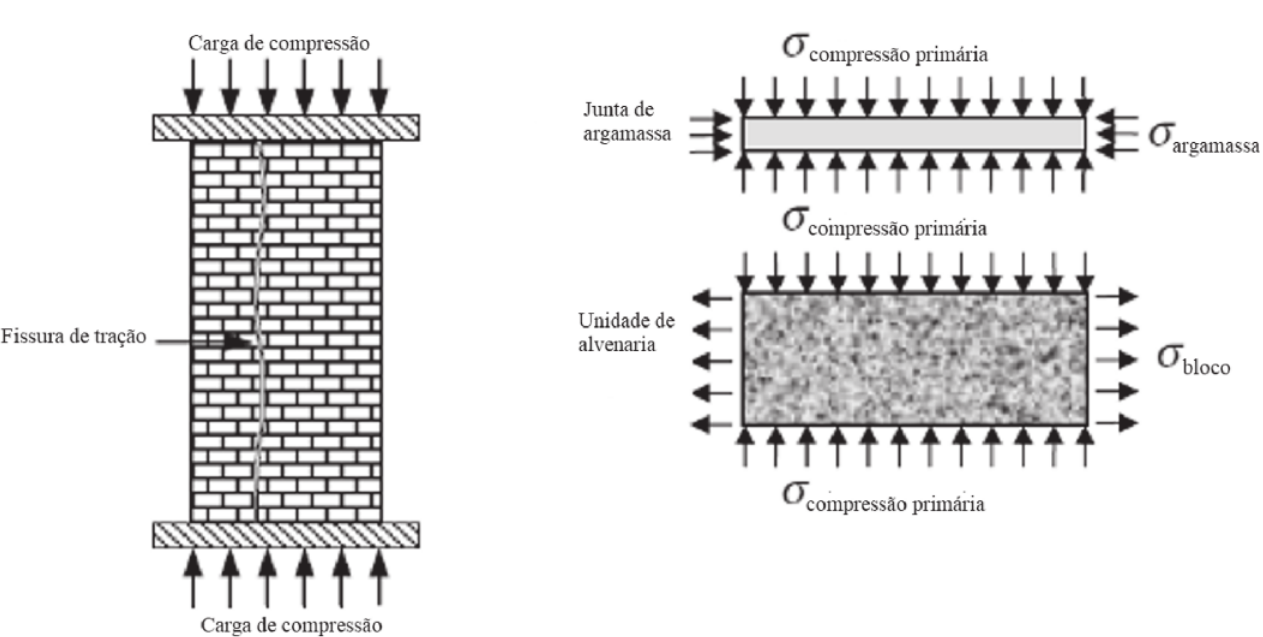
Modo de ruptura da alvenaria (Hendry et al